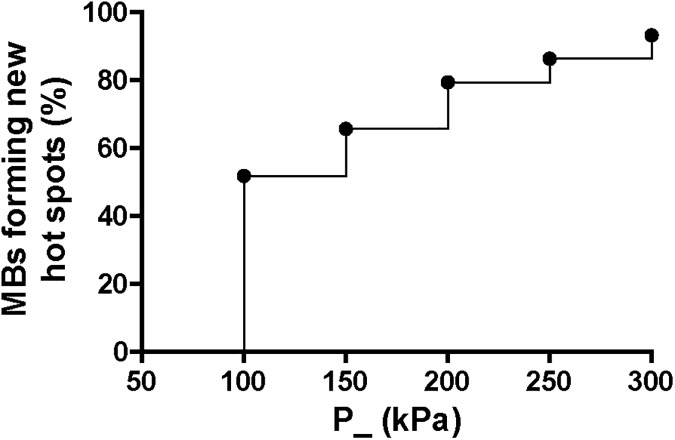
Percentage of microbubbles forming hot spots at frequency of 1 MHz and higher P_. n = 41 microbubbles.